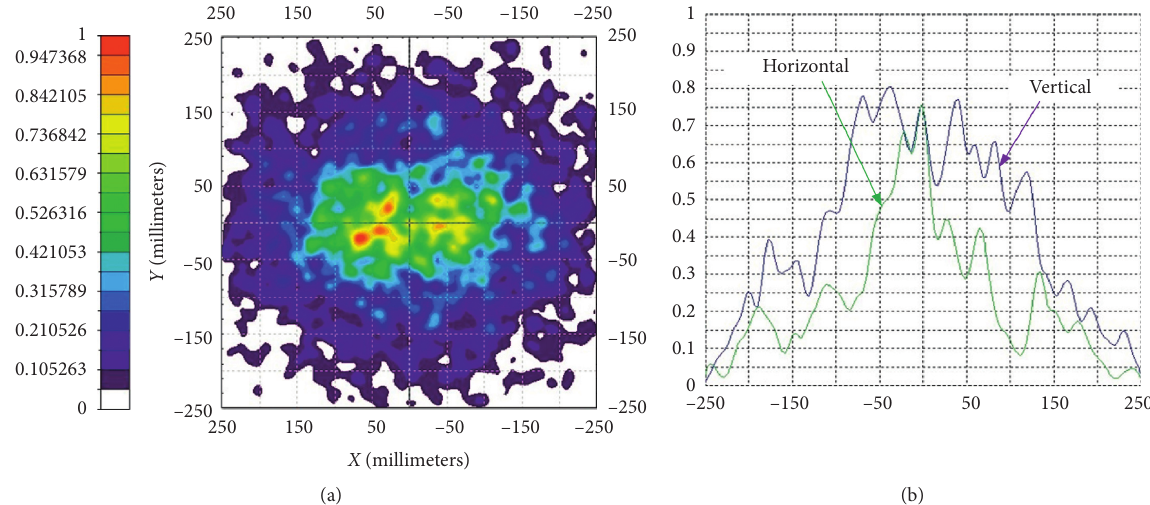
Figure 5: Total-irradiance map diagram of the receiving surface of the compound eye plano-convex lens with 37 monocular lenses and sunflower-shaped plano-convex lens array.